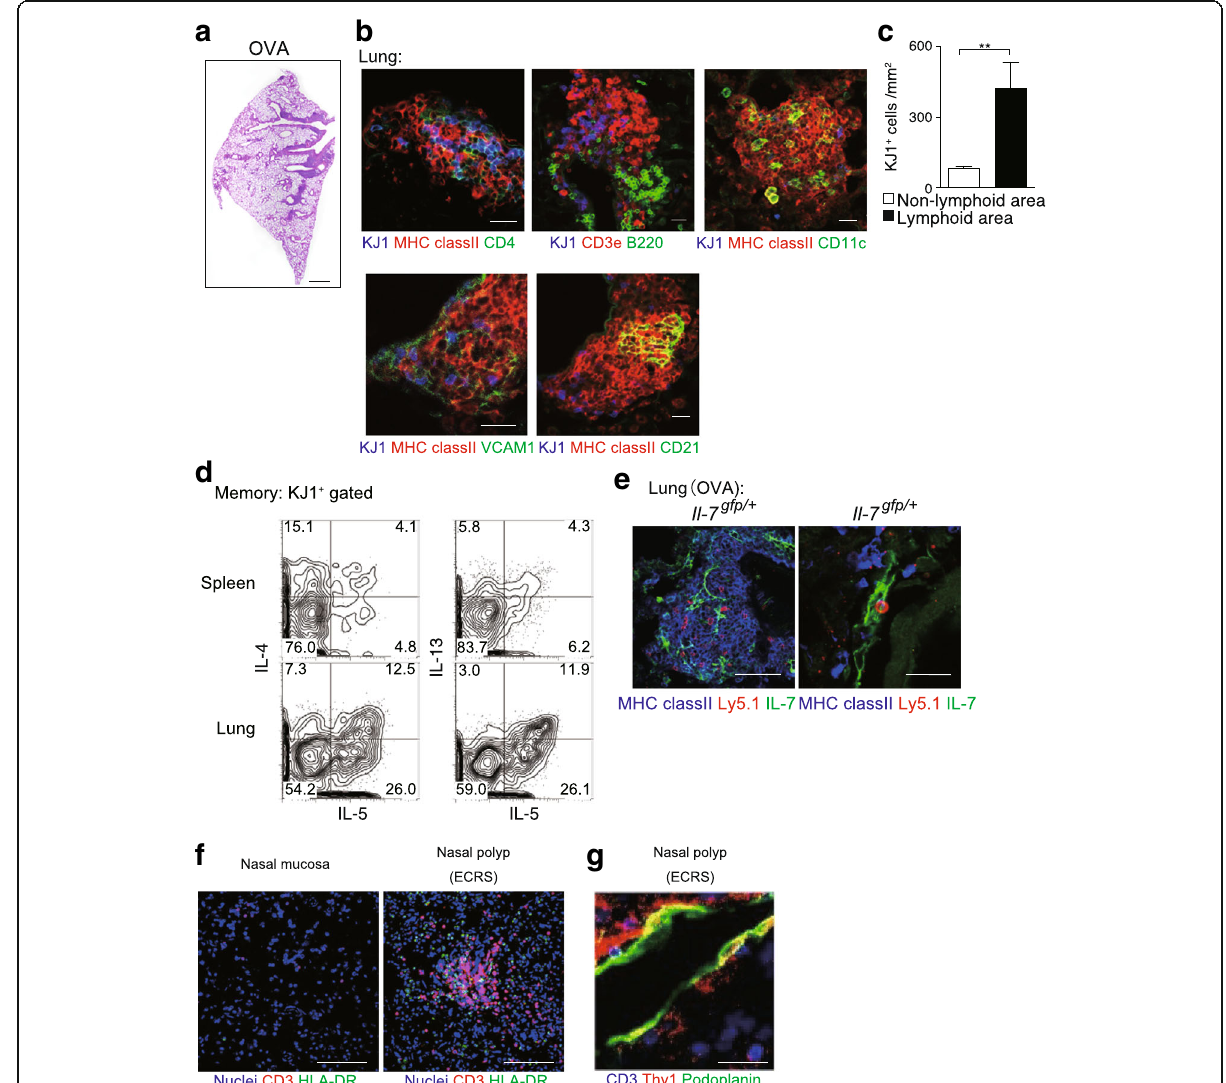
Fig. 2 iBALT is induced under conditions of chronic allergic inflammation in both mice and humans. a The intra-nasal administration of the antigen resulted in iBALT formation in the lungs of mice. b iBALT included memory Th2 cells, MHC-class ll + cells, B220 + cells, CD11c + cells, VCAM1 + cells, and CD21 + cells. c The memory Th2 cells showed greater accumulation in the lymphoid areas than in the non-lymphoid areas. d Memory Th2 cells in the lung produced more Th2 cytokines compared to those from memory Th2 cells in the spleen. e IL-7-producing cells and Ly5.1 + memory Th2 cells were detected in mice iBALT. f Ectopic lymphoid structures were generated in the polyps of patients with ECRS. g Podoplanin-positive lymphatics were increased in the polyps of patients with ECRS. ( Shinoda et al. PNAS (2016) Copyright (2016) National Academy of Sciences). KJ: OVA-specific T cell flox mice crossed with Tie2 -Cre transgenic mice, in which the mouse endothelial-specific receptor tyrosine kinase (Tie2) promoter directs expression of Cre recombinase, to investigate the role of IL-7 produced by LECs. When iBALT was induced using Il-7 fl/fl Tie2-Cre + Tg mice as hosts, iBALT formation was impaired in the lung of Il-7 fl/fl Tie2-Cre + Tg mice. We also detected decreased numbers of memory Th2 cells in the lung. Taken together, these findings indicate that Thy1 + IL-7 + lymphatic endothelial cells (LECs) support the memory Th2 cell survival in iBALT in vivo.